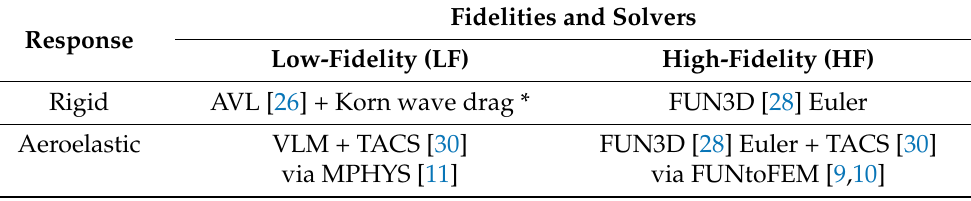
Table 1. Modeling fidelity by response type. (“*” denotes gradient computation through forward differencing of tool